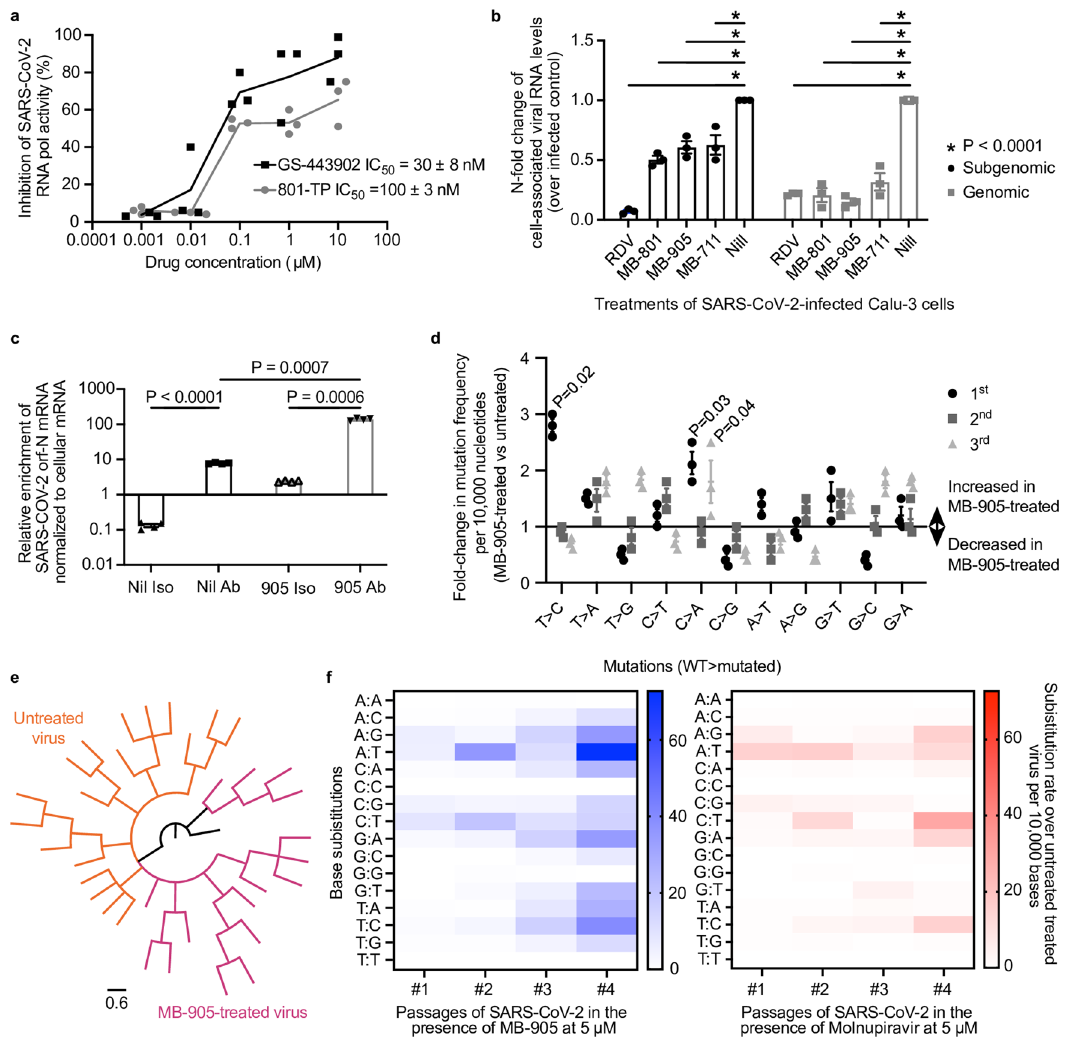
Fig. 2 | MB905 inhibits SARS-CoV-2 RNA synthesis. SARS-CoV-2 RNApolymerase was incubated with a template/primer, NTPs and MgCl 2 for 3h at 37°C in the absence and presence of the antiviral MB-905-ribose (801) triphosphate (801-TP) andGS-443902( n =3).Pyrophosphatereleasewasquanti fi edbyluminescentassay (Lonza Bioscience, LT07-610). ( n =3) ( a ). Cell monolayers, of calu-3-infected cells treatedwith10 µ Mofthecompoundsfor48h,werelysed,totalRNAwasextracted,- and quanti fi ed by RT ‒ PCR to ORF1 and ORFN mRNA ( n =3; mean values ± SEM; ordinarytwo-wayANOVA)( b ).Cell-associatedviralRNAfrommock-andSARS-CoV- 2-infected calu-3 cells treated or not with MB-905 was incubated with anti-kinetin antibody (Ab) or nonspeci fi c IgG (isotype control; Iso) coupled with protein A conjugated to magnetic beads. After washing, ORFN mRNA and